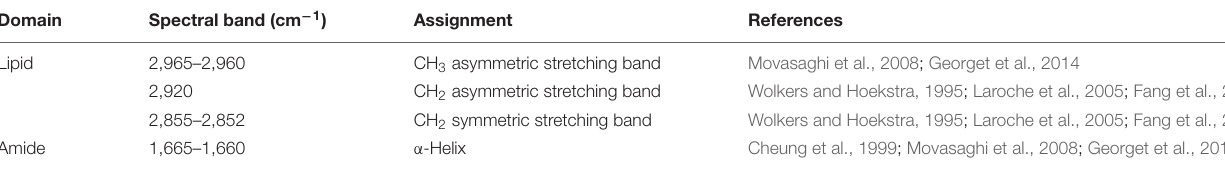
TABLE 1 | Main spectral regions indicating specific protein and lipid spore structures.